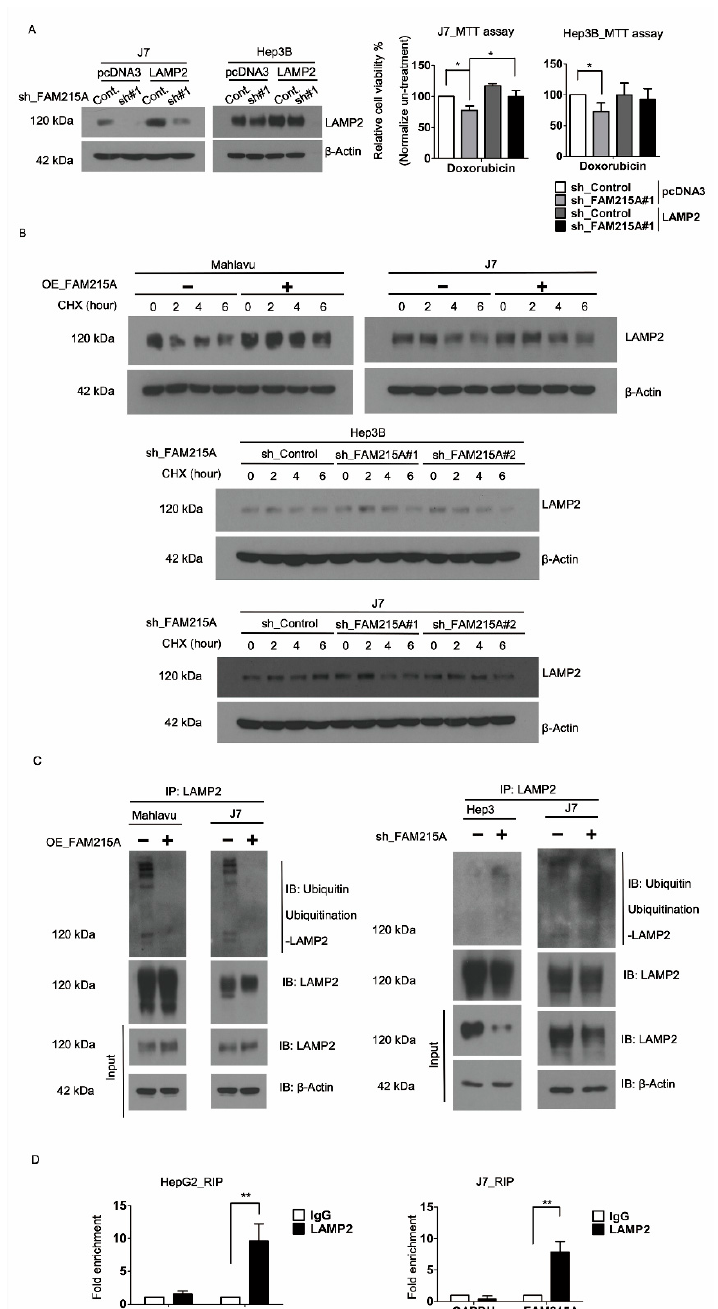
Figure 5. FAM215A confers Doxroubicin resistance in HCC by affecting the LAMP2 stability. ( A ) To restore LAMP2 expression in FAM215A knockdown of Hep3B and J7 cell lines detected by Western blot. The cell viability assay was performed on MTT assay with Doxroubicin 5 μ M 24 h. ( B ) The protein stability of LAMP2 was assessed by treatment CHX 10 μ g for 1–6 h in FAM215A-expressing or knockdown cells detected by Western blot. ( C ) The ubiquitination of LAMP2 was assessed by immunoprecipitation (IP) that was treated with MG132 for 4 h in FAM215A-expressing or knockdown cells. ( D ) Interaction of FAM215A and LAMP2 assessed by RNA immunoprecipitation (RIP) in HepG2 and J7 cells, IgG as the control antibody and GAPDH as the negative control. β -Actin and 18s rRNA were used as the loading controls. Data are presented as means ± SD of three independent experiments (*, p < 0.05; **, p < 0.01) .